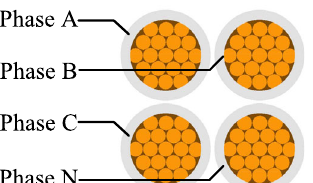
Fig. 3 480 V cable structure